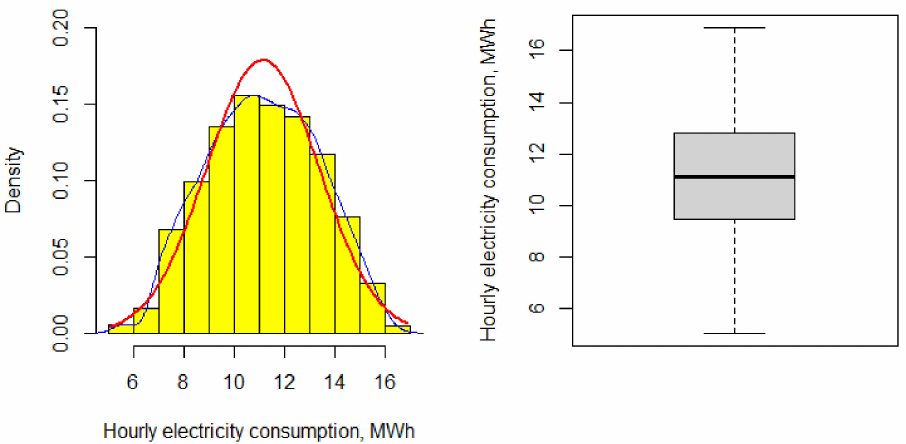
Figure 10. The graphical representation of the distribution of hourly electricity consumption for the M3 object. Source: own study in the RStudio